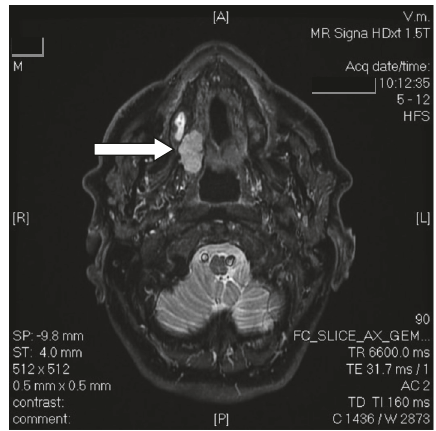
Figure 1: Preoperative horizontal MRI scan indicating the location (white arrow) of the adenocarcinoma of the right palatomaxillary region. [L]: left side; [R]: right side; [A]: anterior aspect; [P]: posterior aspect.